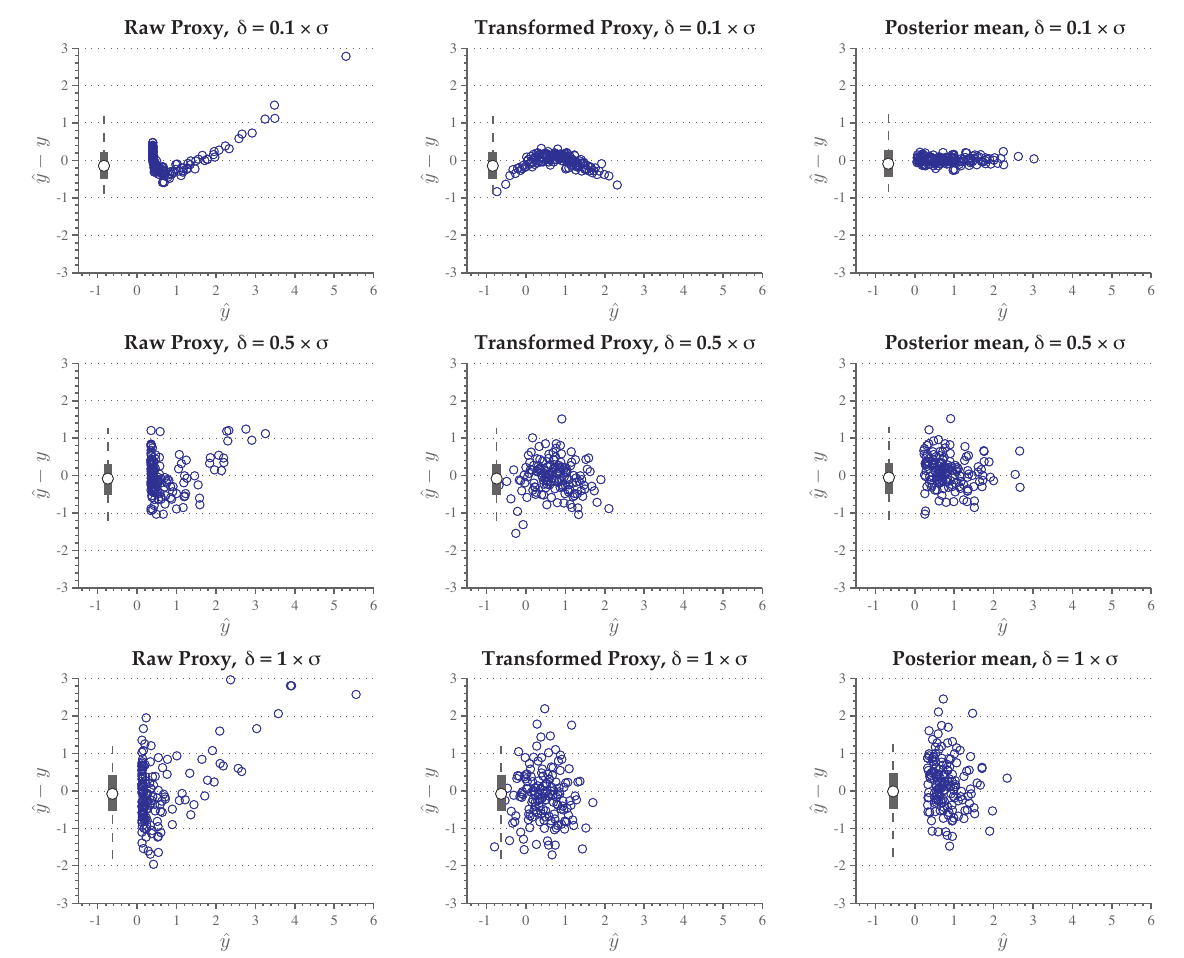
Figure 5. Residuals (differences between estimated and true values of the climate) as a function of the estimated climate. The three inference methods (columns) are compared for three values of δ (rows). Blue circles: residuals when p > 0; box plots: the distribution of residuals for p = 0. Whiskers extend to the 2.5% and 97.5% quantiles; boxes denote the 25% and 75% quantiles; circles mark the median. The middle row corresponds to the simulated proxy plotted in Fig.